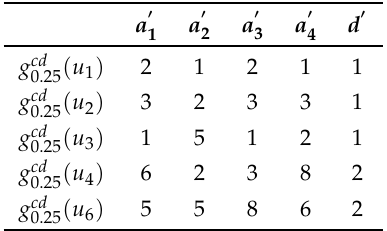
Table 3. Concept dependent granular decision system for ( U , A , d ) and radius